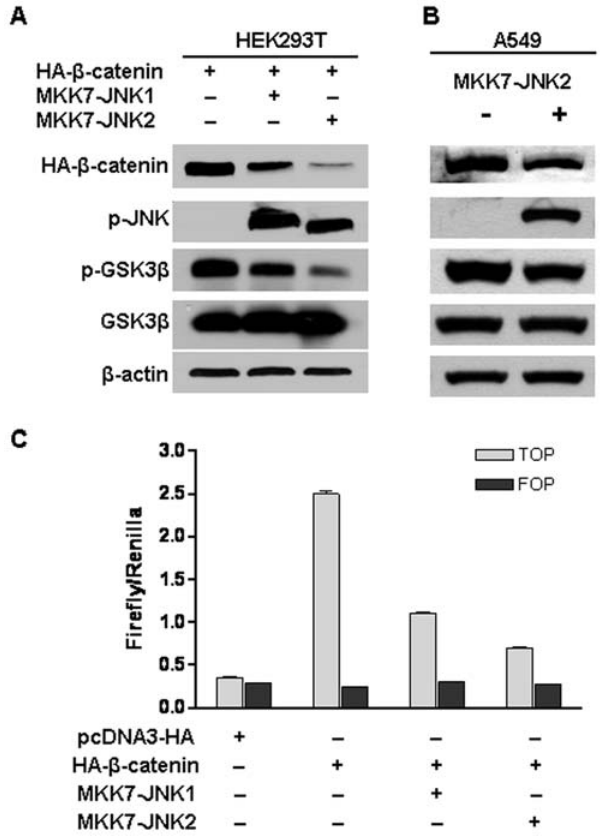
Figure 1. Active JNK2 downregulated b -catenin expression, inhibited its transcriptional activity and reduced GSK3 b phosphorylation. (A) Active JNK2 suppressed b -catenin expression and GSK3 b phosphorylation in HEK293T cells. HEK293T cells were transfected with pcDNA3-HA- b -catenin together with pcDNA3-Flag- MKK7-JNK1 or pcDNA3-Flag-MKK7-JNK2. Forty-eight hours after trans- fection, cells were harvested for immunoblotting analysis to detect the alterations of HA- b -catenin, p-JNK, p-c-Jun, phospho-Ser 9 GSK3 b , and GSK3 b . b -actin served as loading control. (B) Active JNK2 reduced GSK3 b phosphorylation and downregulated b -catenin expression in